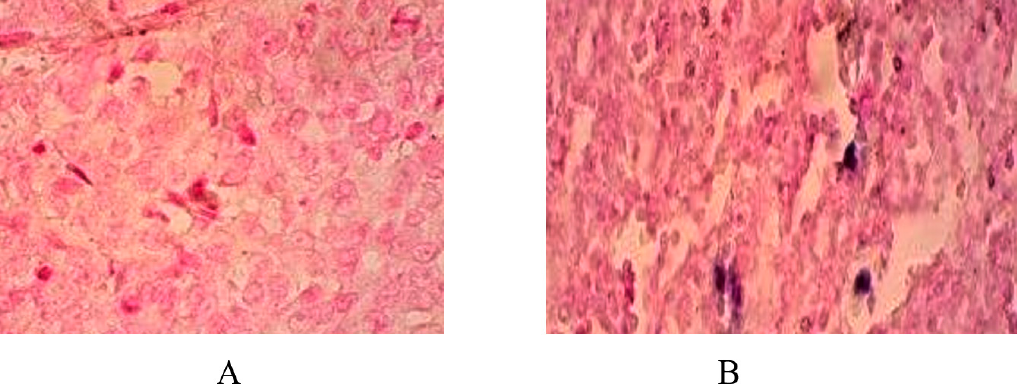
Fig. 1. Oral sections in OSCC: CISH reaction for hCMV detection ׳40. (A): Negative reaction; (B) positive reaction with low score and strong signal intensity.